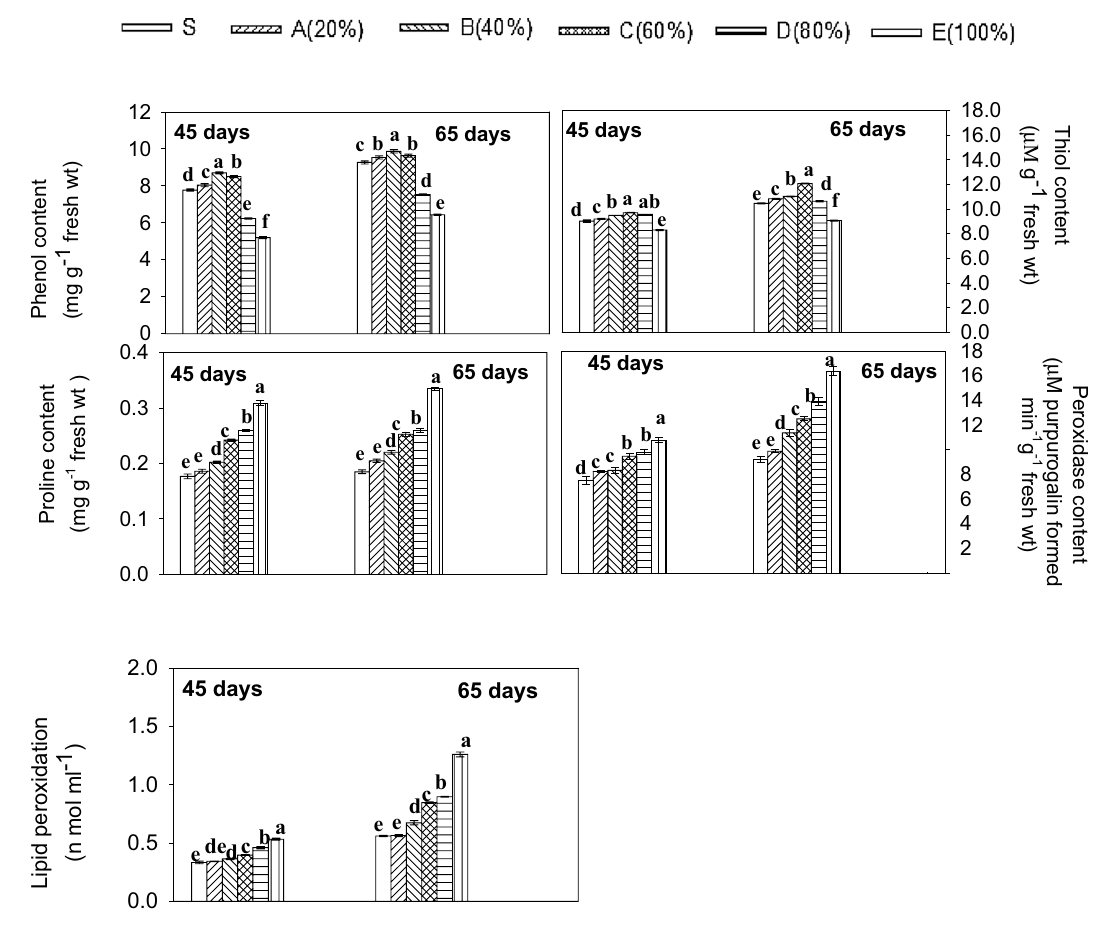
Fig. 2 Phenol, proline, thiol, peroxidase, and lipid peroxidase content in lady’s finger plants grown at different MSWVC amendments at two dif- ferent ages (Mean ± 1 SE). Bars with different letters in each group show significant difference at p <